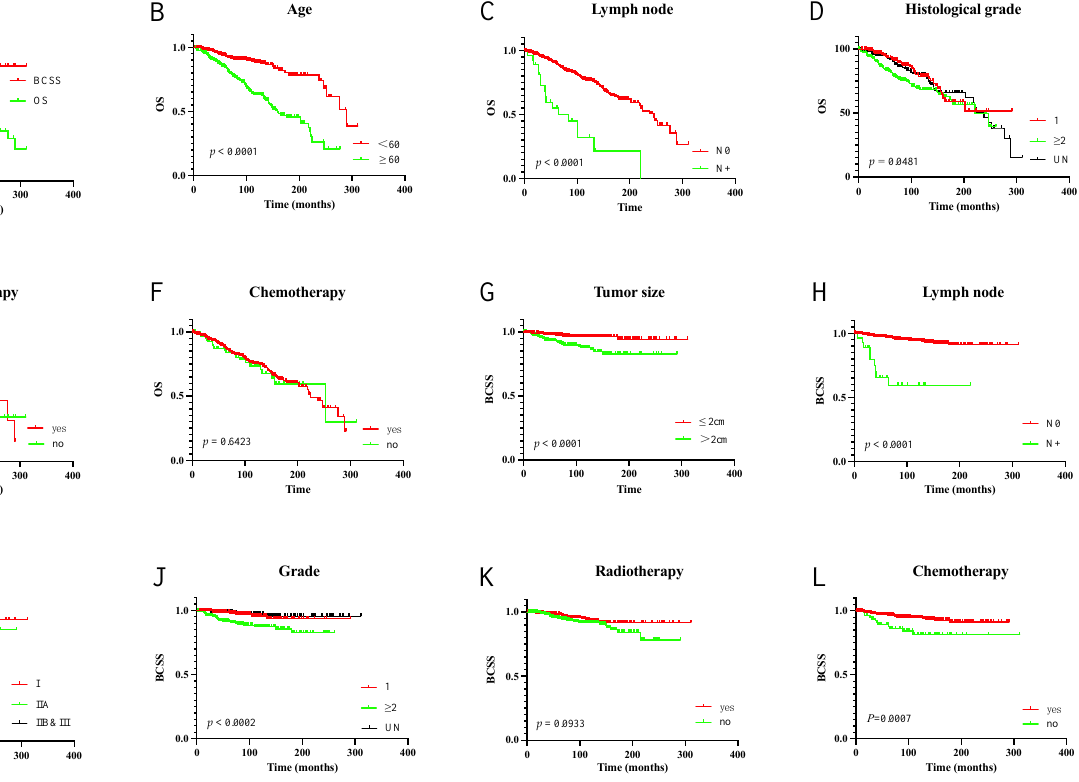
Figure 2. The OS and BCSS of overall population and different groups. ( A ): the OS and BCSS of the overall population; ( B – F ): the OS of different subgroups of age ( B ), lymph node ( C ), histological grade ( D ), radiotherapy ( E ), chemotherapy ( F ); ( G – L ): the BCSS of different subgroups of tumor size ( G ), lymph node ( H ), stage ( I ), grade ( J ), radiotherapy ( K ), chemotherapy ( L ). Univariate analysis showed that patients aged ≥ 60 years at diagnosis, with lymph node metastasis, stage IIB and III, and histological grade ≥ 2, and patients not receiving postoperative radiotherapy had worse OS ( p < 0.05) (Table 2). Patients with tumors >2 cm, lymph node metastasis, advanced stage, high histological grade, and patients not receiving radiotherapy had worse BCSS ( p < 0.05) (Figure 2). Table 2. Univariate and multivariate analyses of factors influencing OS and BCSS in ACCB .